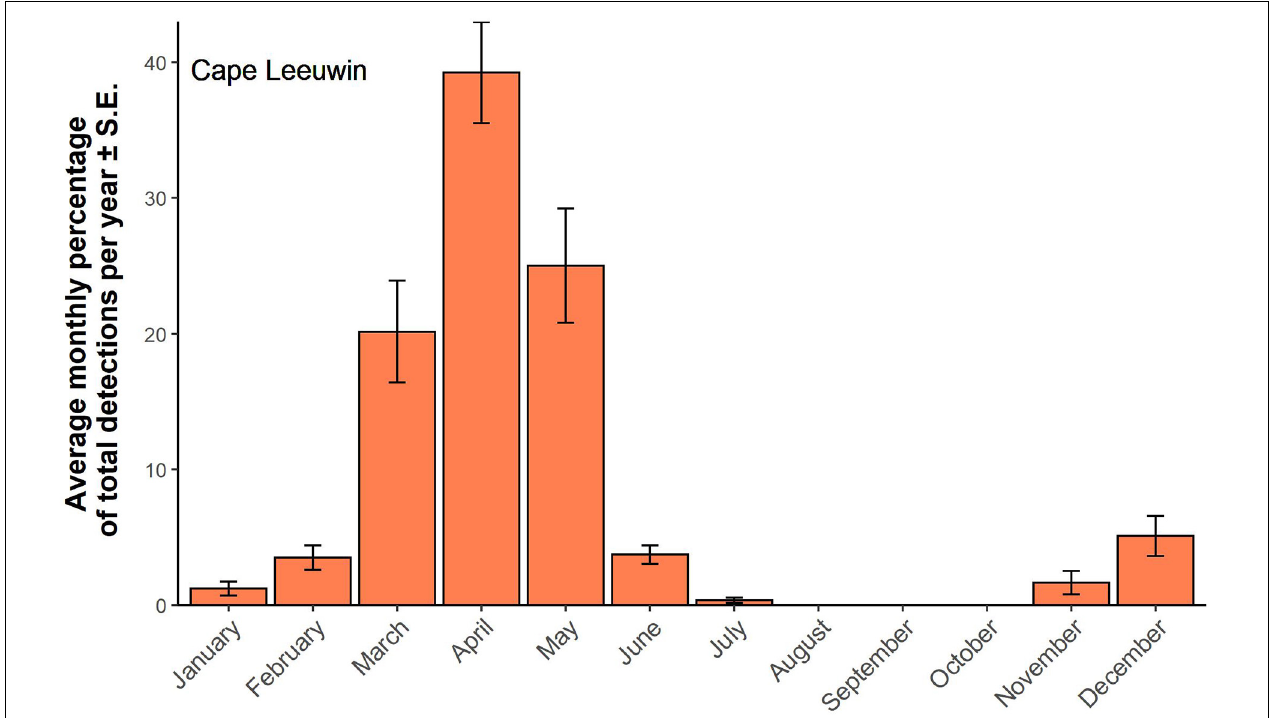
FIGURE 6 | SEIO call detections at Cape Leeuwin. Averaged monthly detections ± SE. Monthly detections have been standardized by calculating the monthly percentage of total detections per year. Monthly detections were averaged over 16 years of available data.